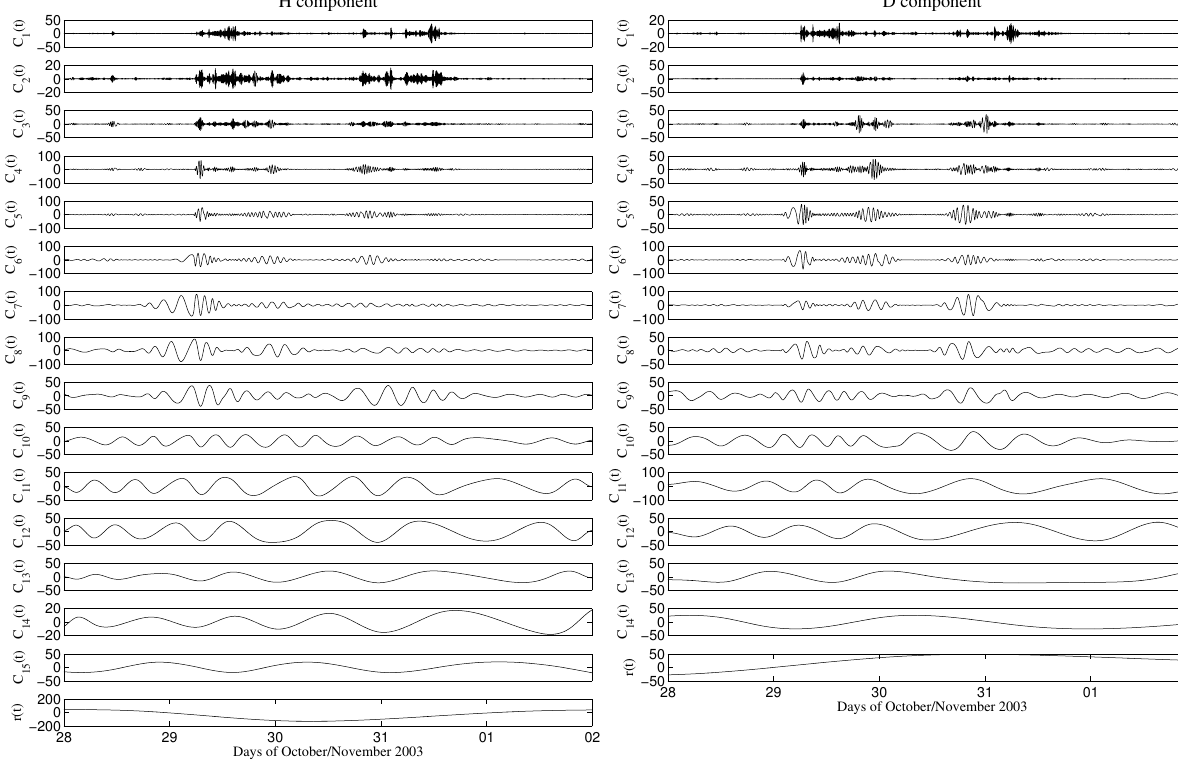
Figure 10. Halloween super storm, 28 October–1 November 2003: empirical modes extracted via EMD from H (left panels) and D (right panels) components recorded at AQU observatory. The modes and the residue are expressed in nanotesla, and the time resolution is